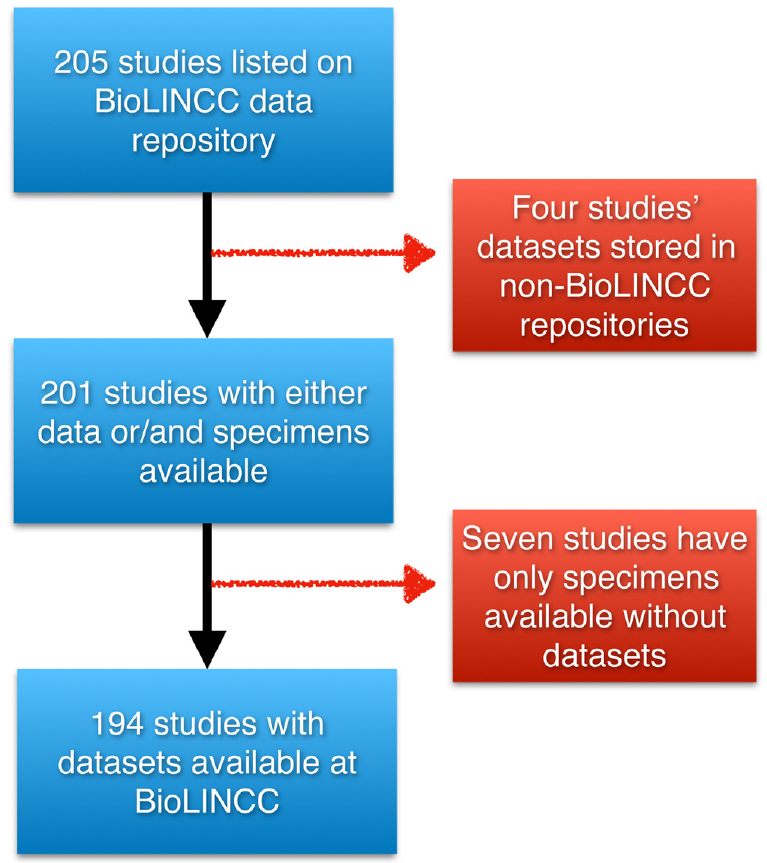
Figure 1. The initial datasets and the final datasets included after applying exclusion